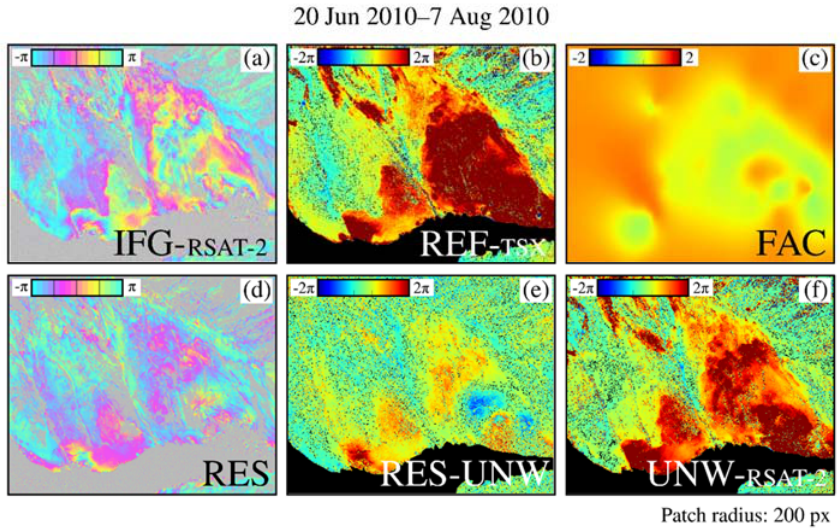
Figure 9. Warp demodulation result for a representative RADARSAT-2 interferogram (C-Band, 3 m ground range resolution, 24-day repeat cycle) covering 2 cycles. ( a ) IFG-RSAT-2, to-be-demodulated interferogram (wrapped); ( b ) REF-TSX, reference interferogram (unwrapped); ( c ) FAC, demodulation factor; ( d ) RES: demodulation residual (wrapped); ( e ) RES-UNW: demodulation residual (unwrapped); and ( f ) UNW-RSAT-2, demodulated interferogram. The unwrapped phase in ( b , e , f ) is clipped to ± 2 π . The demodulation patch radius is 200 pixels.